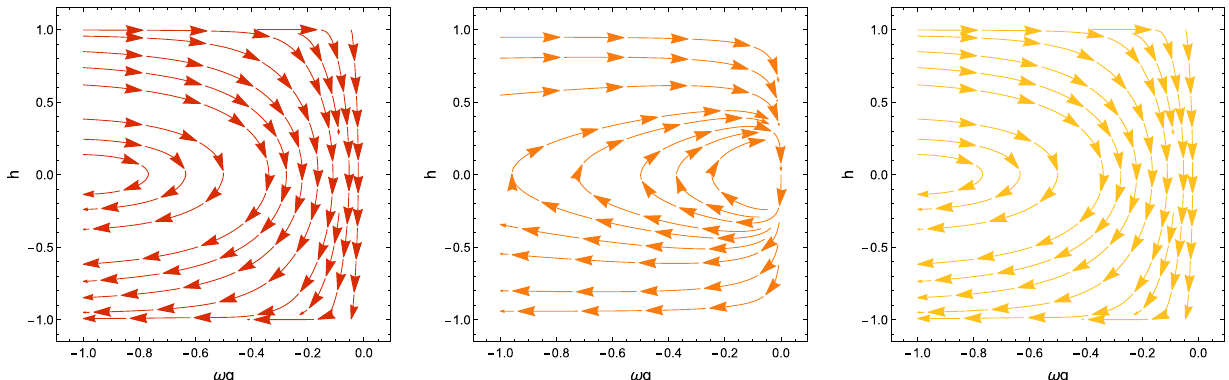
β 2 and for three different values , ω m = 12 (γ − 1 ) 3 2 − γ